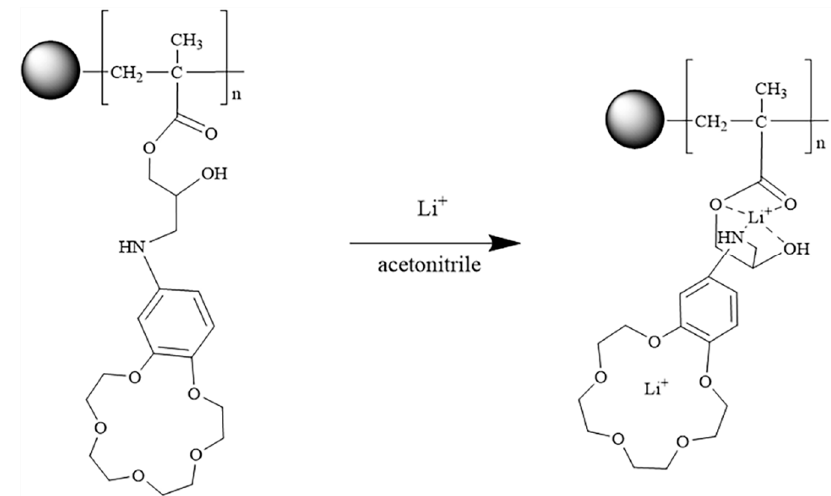
Figure 8. Possible adsorption mechanism of MCM- g -AB15C5 towards Li +.